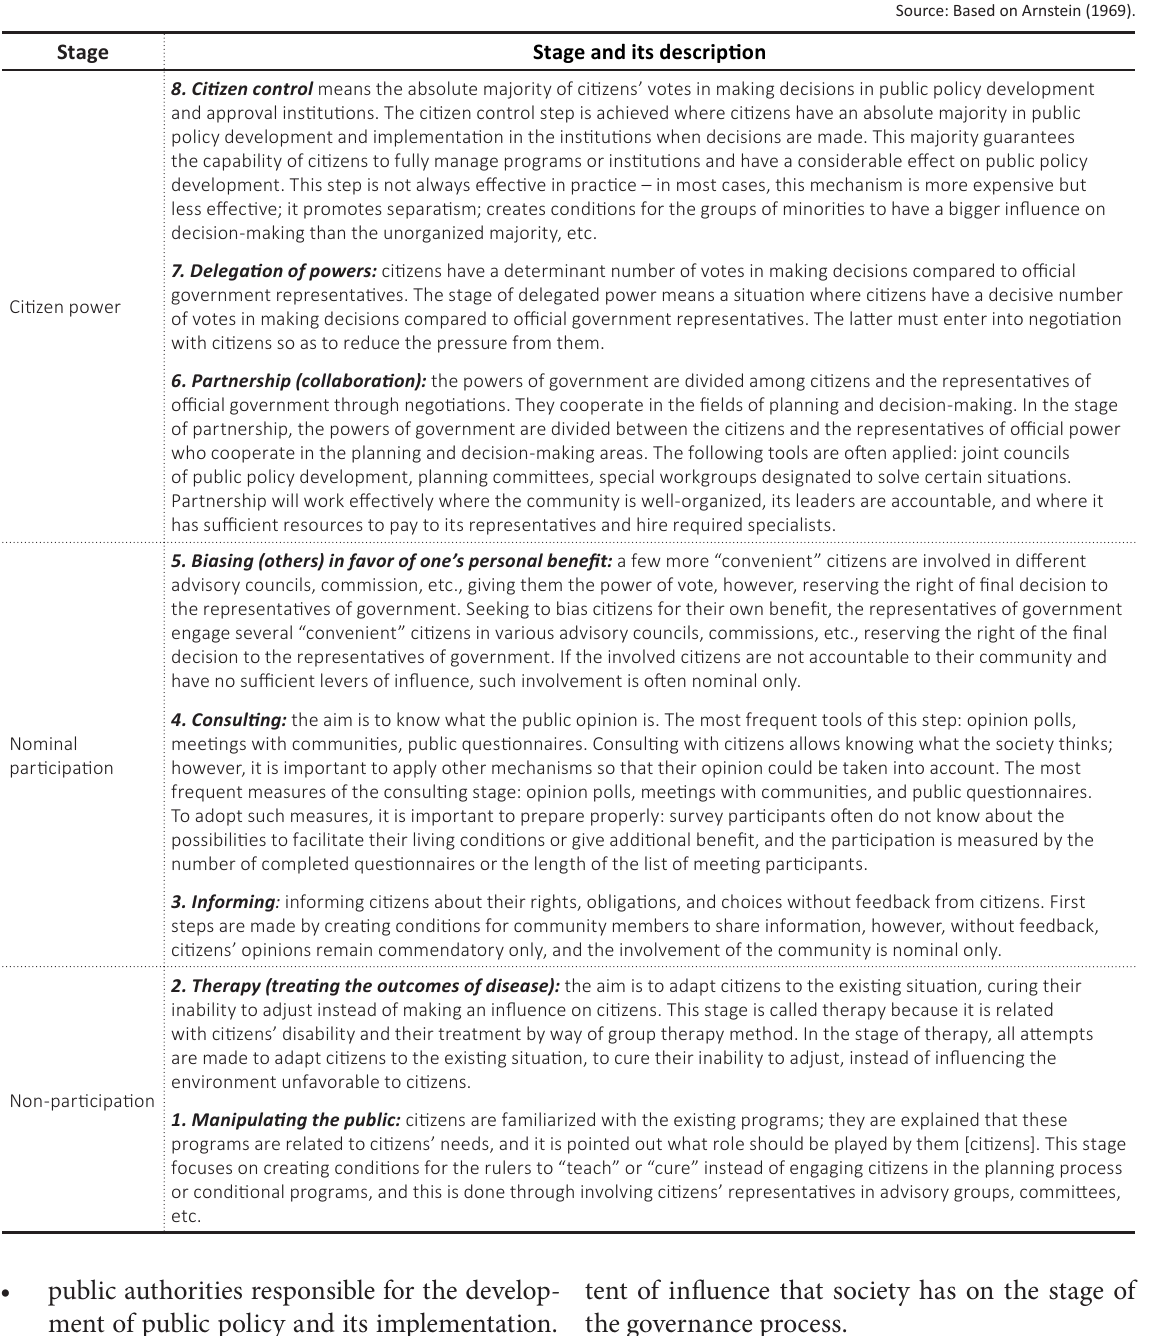
Table 1. Stages of public participation